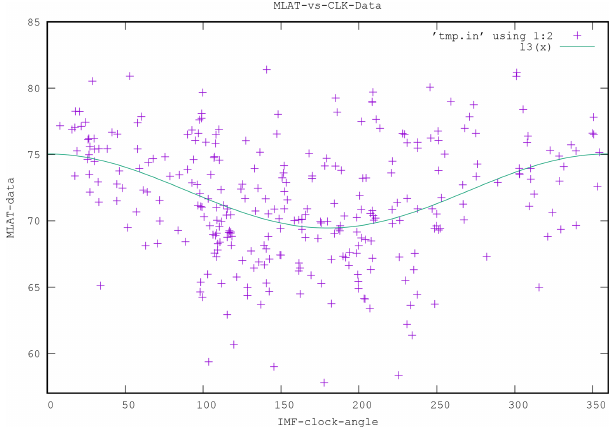
Figure 9. Correlation between the OCB latitudes obtained from DMSP and from OpenGGCM. The blue line is a linear fit, and the green line represents an ideal correlation.